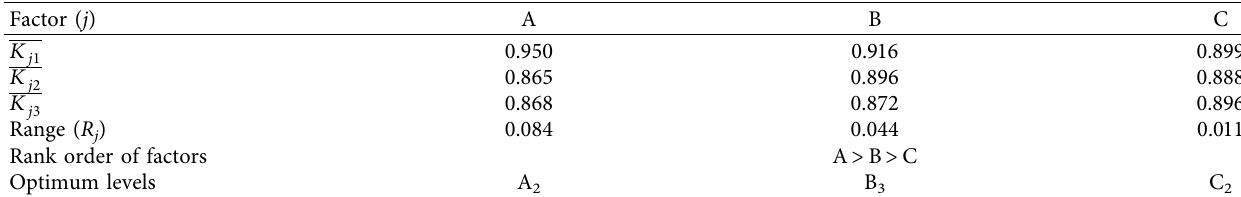
Table 5: Range analysis results of relative wear rates.